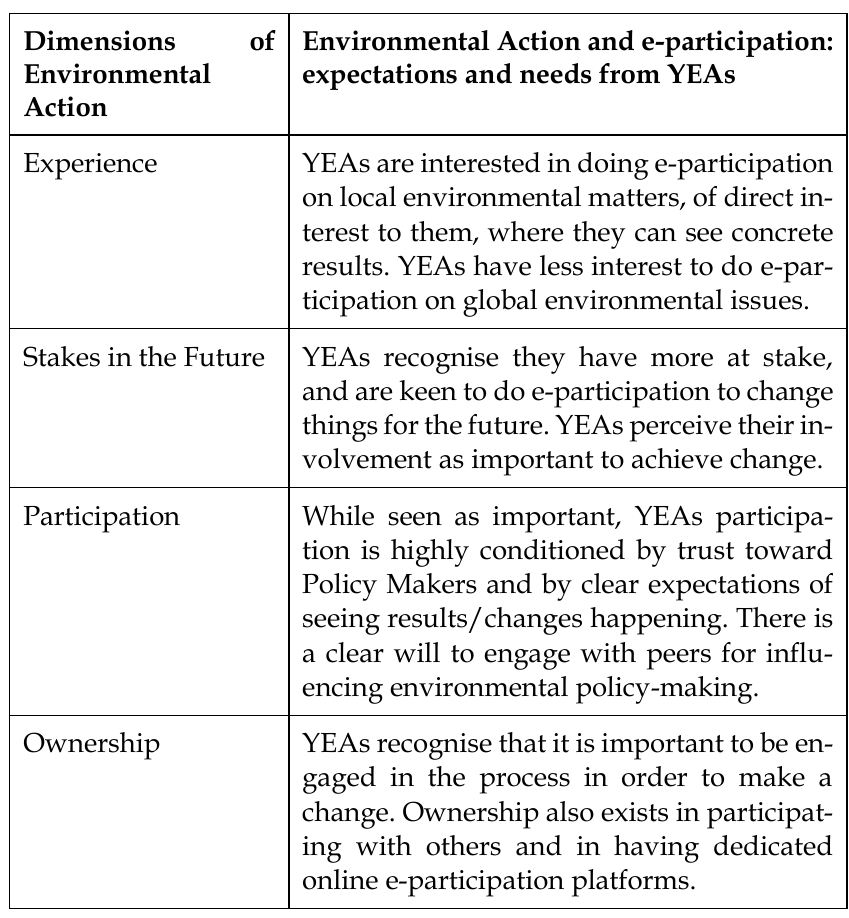
Table 3: Environmental action and e-participation